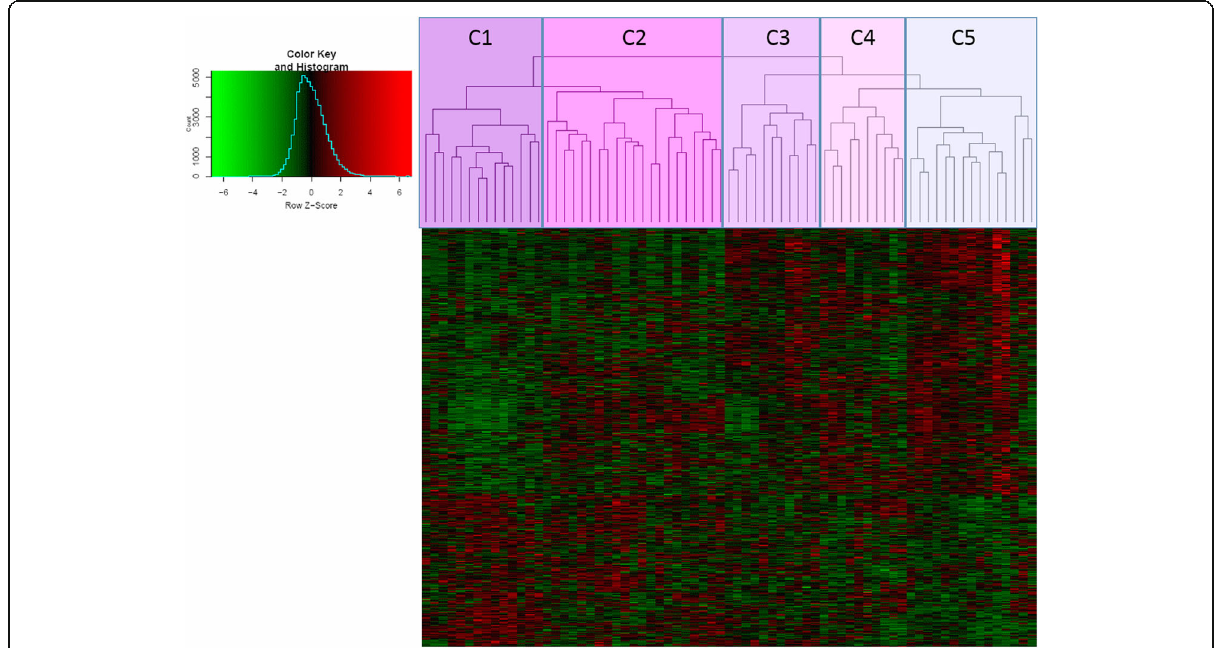
Fig. 1 Hierarchical clustering and heatmap of samples in the training set with the 909 probes of the signature. Microarray samples of the 71 patients in the training set are in columns and standardized probes in rows. The five sample clusters obtained are denoted by C1 to C5 in the upper part of the dendrogram